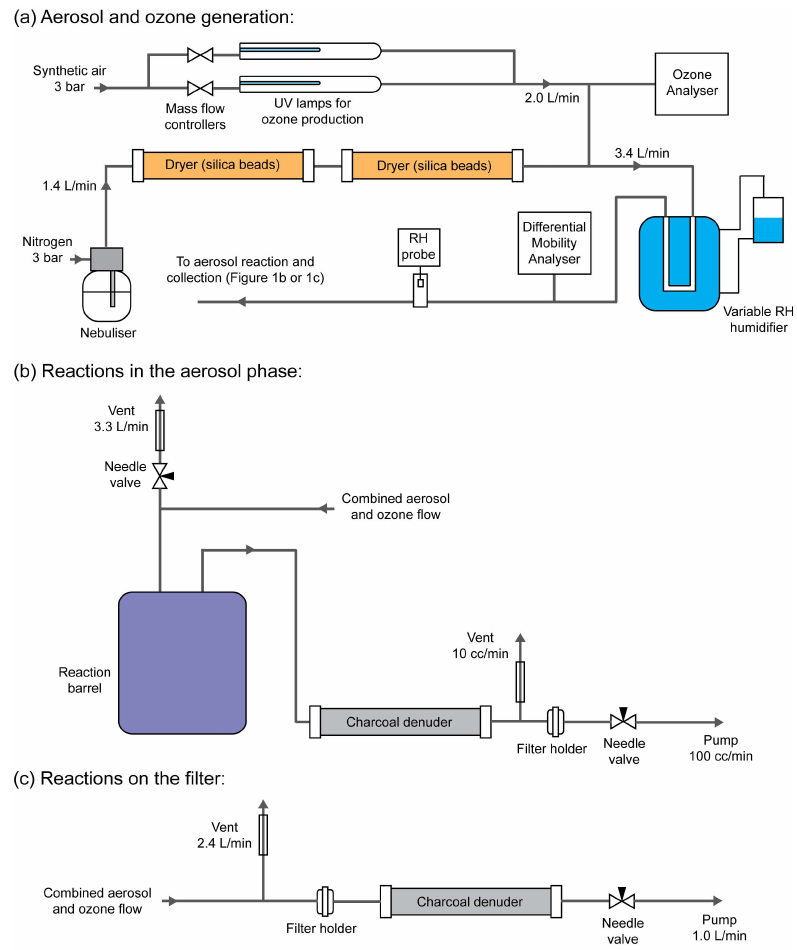
Fig. 1. Schematic diagram of the aerosol flow tube apparatus. Aerosol and ozone flows were generated, humidified (a) and reacted in a 50l barrel (b) or were reacted on a filter (c)